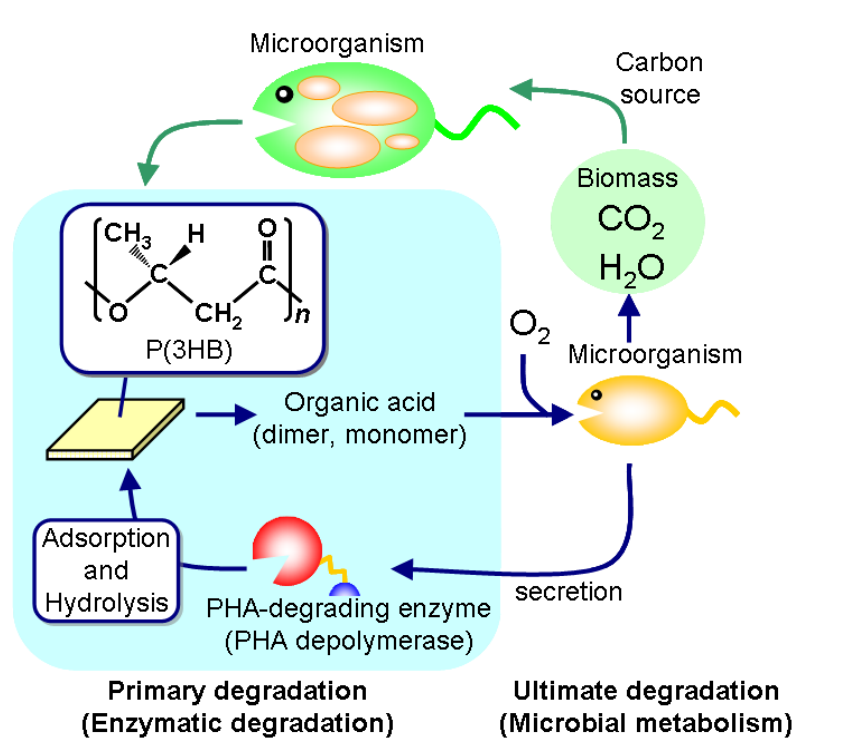
Figure 1. Biosynthesis and biodegradation process of PHA in a natural